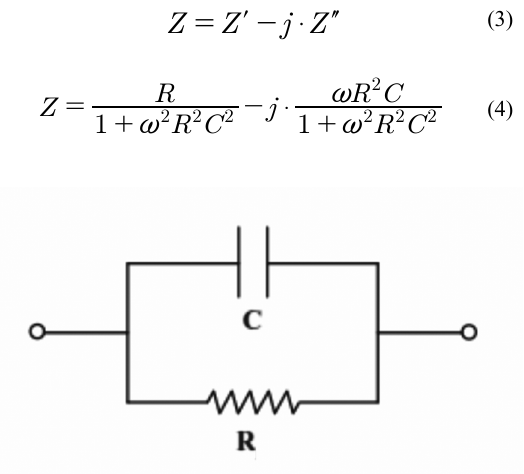
Figure 1. Equivalent circuit for sample measurements DEA.